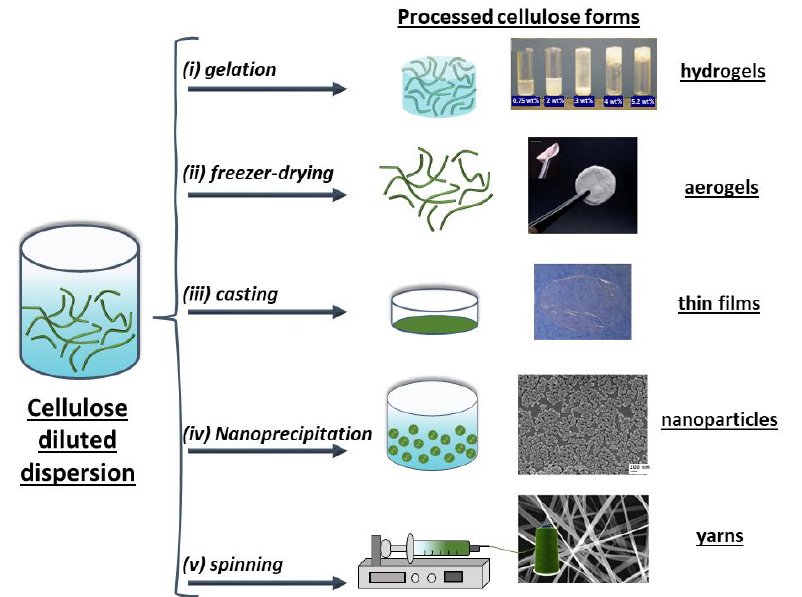
Figure 3. Representation of different approaches for processing cellulose dispersions resulting in (i) hydrogels from cotton CNC suspensions at different CNC concentrations [63], (ii) highly flexible CNF aerogel formed by freezer-drying of a CNF hydrogel [64], (iii) thin films prepared from a 10-times homogenized dispersion of MFC 0.13 wt% [65], (iv) nanoparticles of cellulose acetate (CA) formed by the dropwise adding of water into an 4 mg CA/mL acetone solution [66] and (v) SEM images of cellulose acetate (CA) yarns prepared by electrospinning 17 wt% CA solution in acetone/water (85/15 v / v ) solution [67]. Copyrights: all images have been adapted and reproduced with permission from: (i) © 2014 Wiley Periodicals, Inc (ii) © The Royal Society of Chemistry 2011, (iii) © Springer Science+Business Media B.V. 2010, (iv) © 2008, American Chemical Society, (v) © 2004, American Chemical Society.